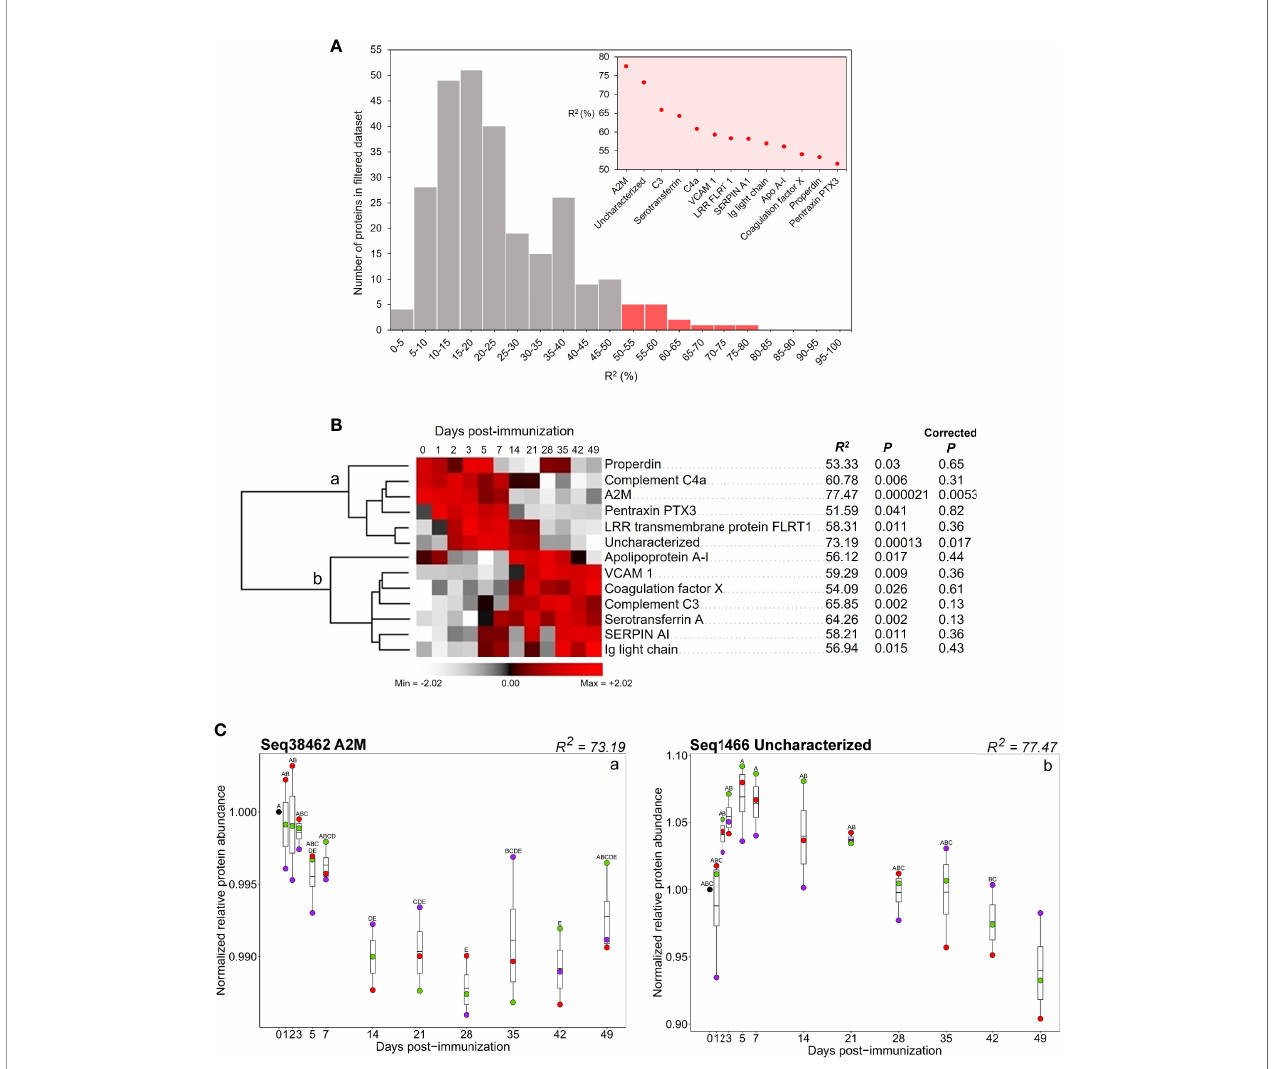
FIGURE 4 | (A) Distribution of ANOVA R 2 values for all proteins in the 260 protein dataset. Red bars indicate the distribution of proteins with the top 5% of R 2 values. Inset shows R 2 values for proteins within the top 5% of R 2 values. (B) Hierarchical clustering of 13 proteins comprising the top 5% of R 2 values. Values for R 2 , P , and corrected P , for each protein, are provided. (C) Abundance pro fi les for two proteins within the set comprising the top 5% of R 2 values (i.e., Figure 3A ) that showed P ≤ 0.05 after BH correction (a) protein translated from transcriptome contig Seq38462 (annotated as A2M); (b) protein translated from Seq1466 (annotated as uncharacterized). Contig numbers for protein annotations: properdin: Seq19272; complement C4a: Seq39499; A2M: Seq38462; pentraxin PTX3: Seq24909; LRR transmembrane protein: Seq2356; uncharacterized: Seq1466; apolipoprotein A-I: Seq1759; VCAM 1: Seq31639; coagulation factor X: Seq7348; complement C3: Seq36113; serotransferrin A: Seq3561; SERPIN AI: Seq7563; Ig light chain: Seq12648. Different letters shown on the plots indicate days with signi fi cantly different protein abundance values (Tukey ’ s